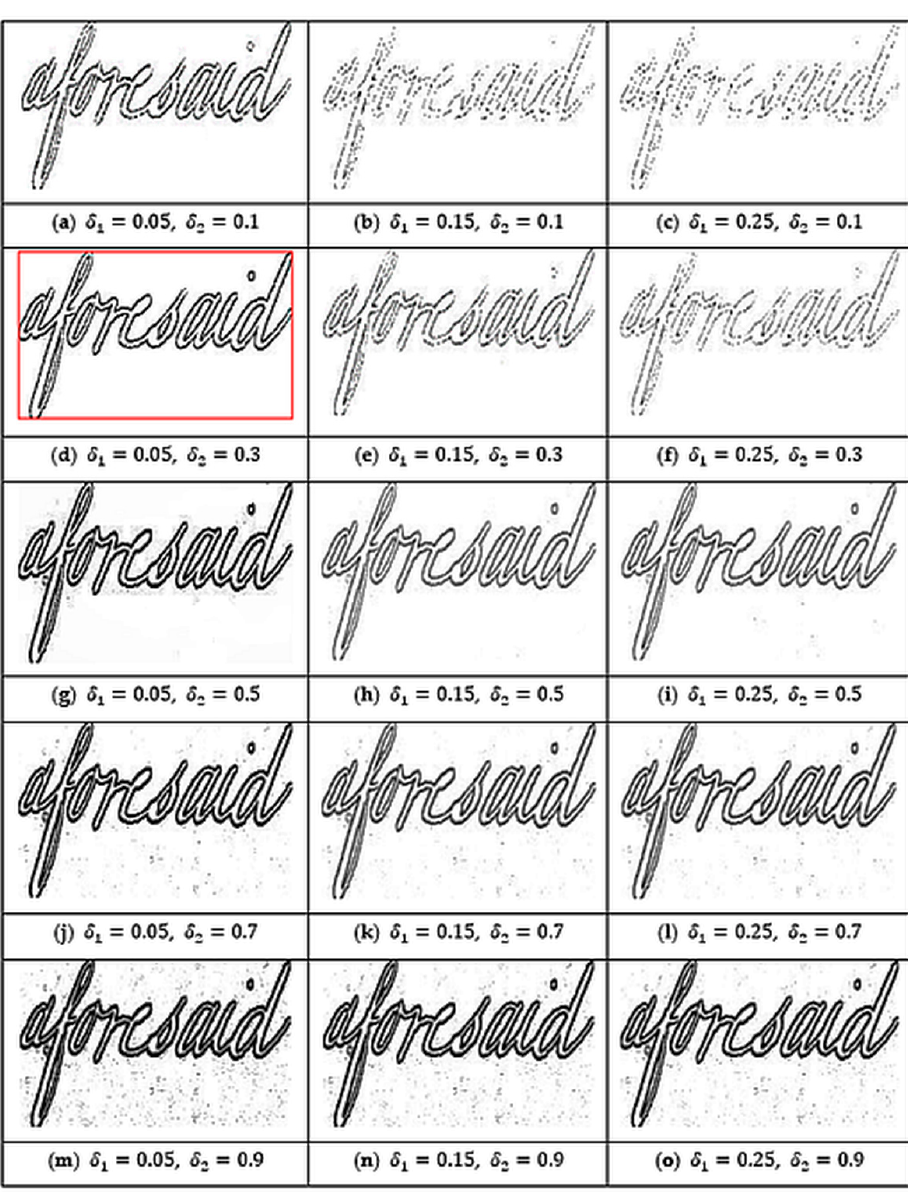
Figure 3. Effect of parameters δ 1 and δ 2 on the pre-processed image of the word ‘aforesaid’. It is seen that the output image ( b ) with δ 1 = 0.05 and δ 2 = 0.3 has the least background noise, coupled with the best prominence of the foreground against the background.